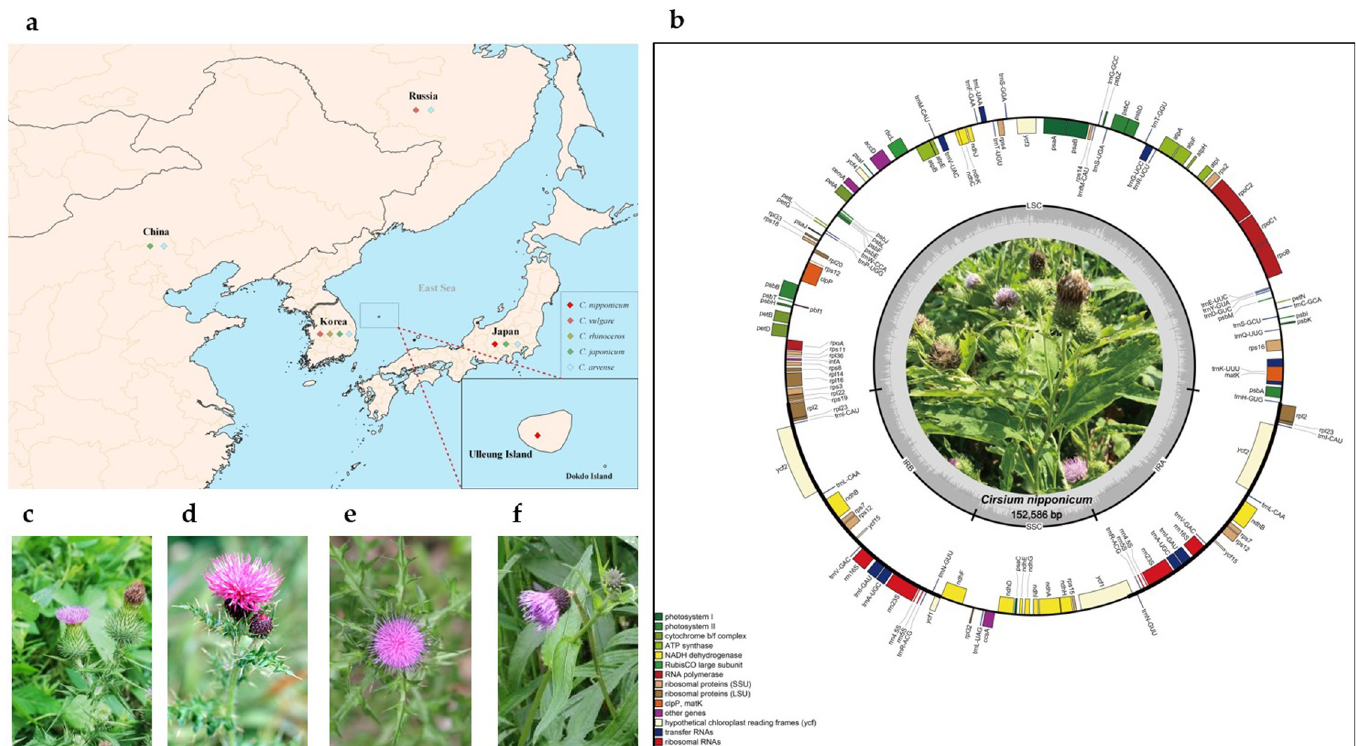
Fig 1. Cirsium species distribution map and chloroplast genetic map. (a) Geographical distribution of Cirsium species around Korea (source: Natural Earth). (b) Genetic map of the C . nipponicum . Genes drawn outside the circle are transcribed counterclockwise, and others inside are transcribed clockwise. (c) C . vulgare distributed near Ulleung Island, provided by Bio Resource Information Service (BRIS). (d) C . rhinoceros distributed near Ulleung Island, provided. (e) C . japonicum distributed near Ulleung Island, provided by National Institute of Biological Resources (NIBR). (f) C . arvense distributed near Ulleung Island, provided by